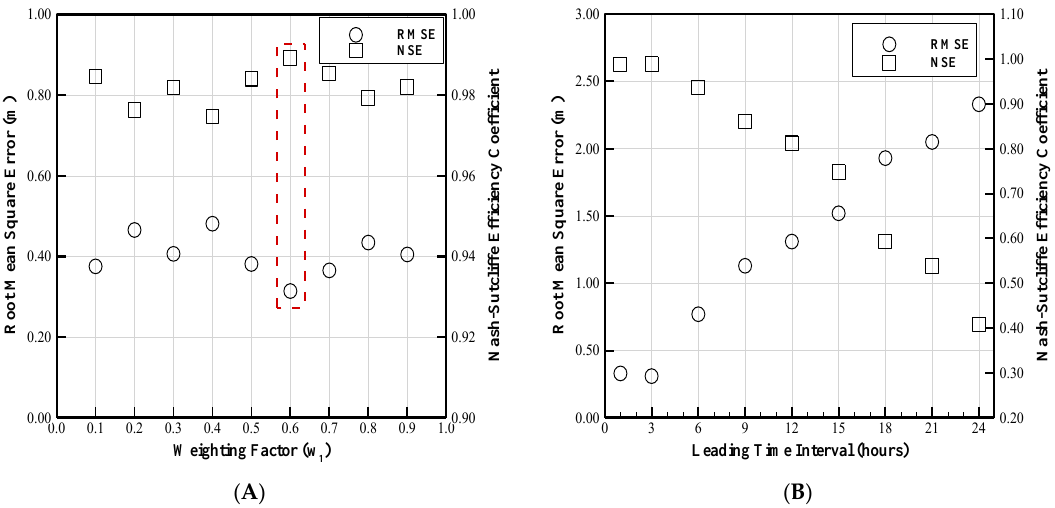
Figure 7. Overall results from Scenarios Ι and Ⅱ . ( A ) Scenario Ι; ( B ) Scenario Ⅱ.